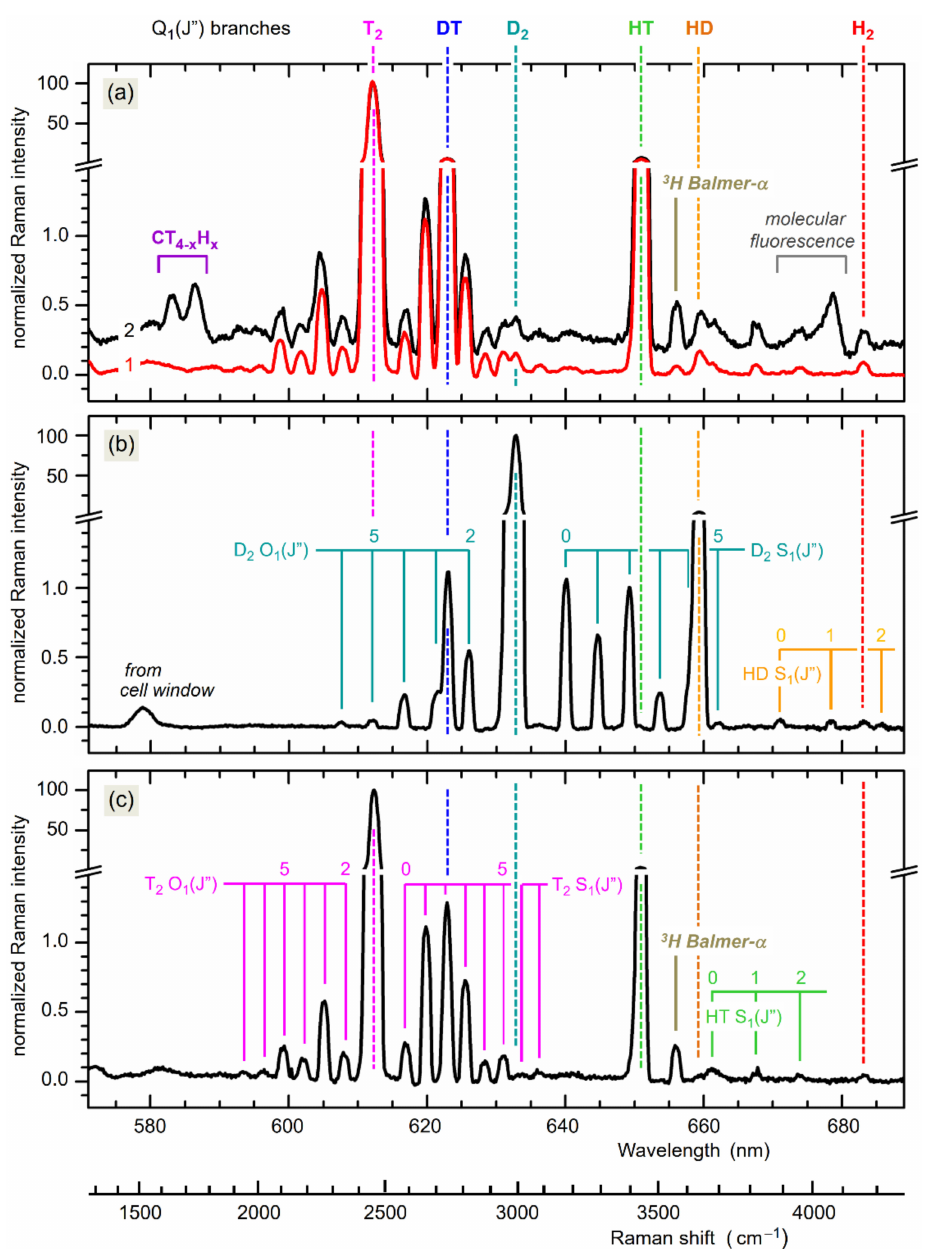
Figure 4. Spectra from selected pre-KATRIN and KATRIN gas circulation campaigns. ( a ) LOOPINO —12 / 2014: Raman spectra from the first day of circulation (trace 1) and after 55 days of circulation (trace 2, offset by + 0.2); the two spectra are o ff set to each other for clarity. ( b ) First tritium (FT)—05 / 2018: Raman spectrum of the gas mixture after two days of circulation. ( c ) KATRIN ramp-up (KNM1)—03 / 2019: Raman spectrum recorded after five days of circulation, during the second ramp-up step. For all spectra, relevant features are annotated; for further detail, see text. Note the split intensity scales to visualize both strong and weak spectral